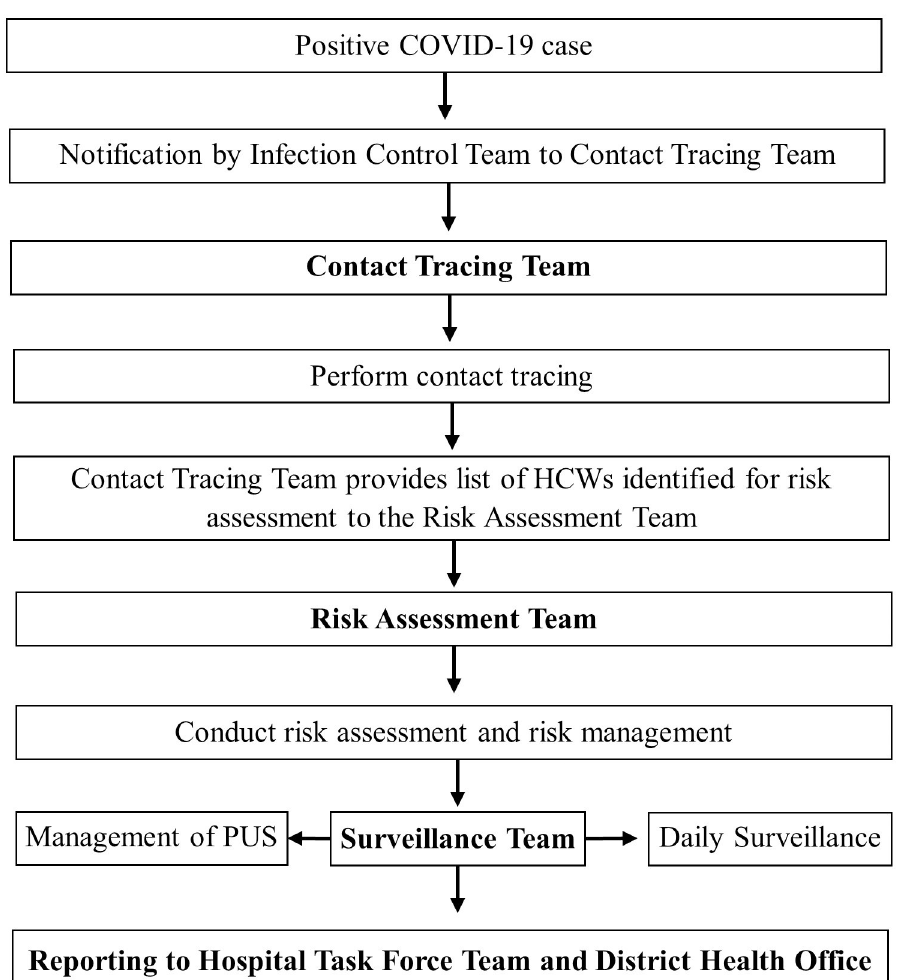
Fig 1. General workflow at the UMMC COVID-19 operations room. � PUS, Person Under